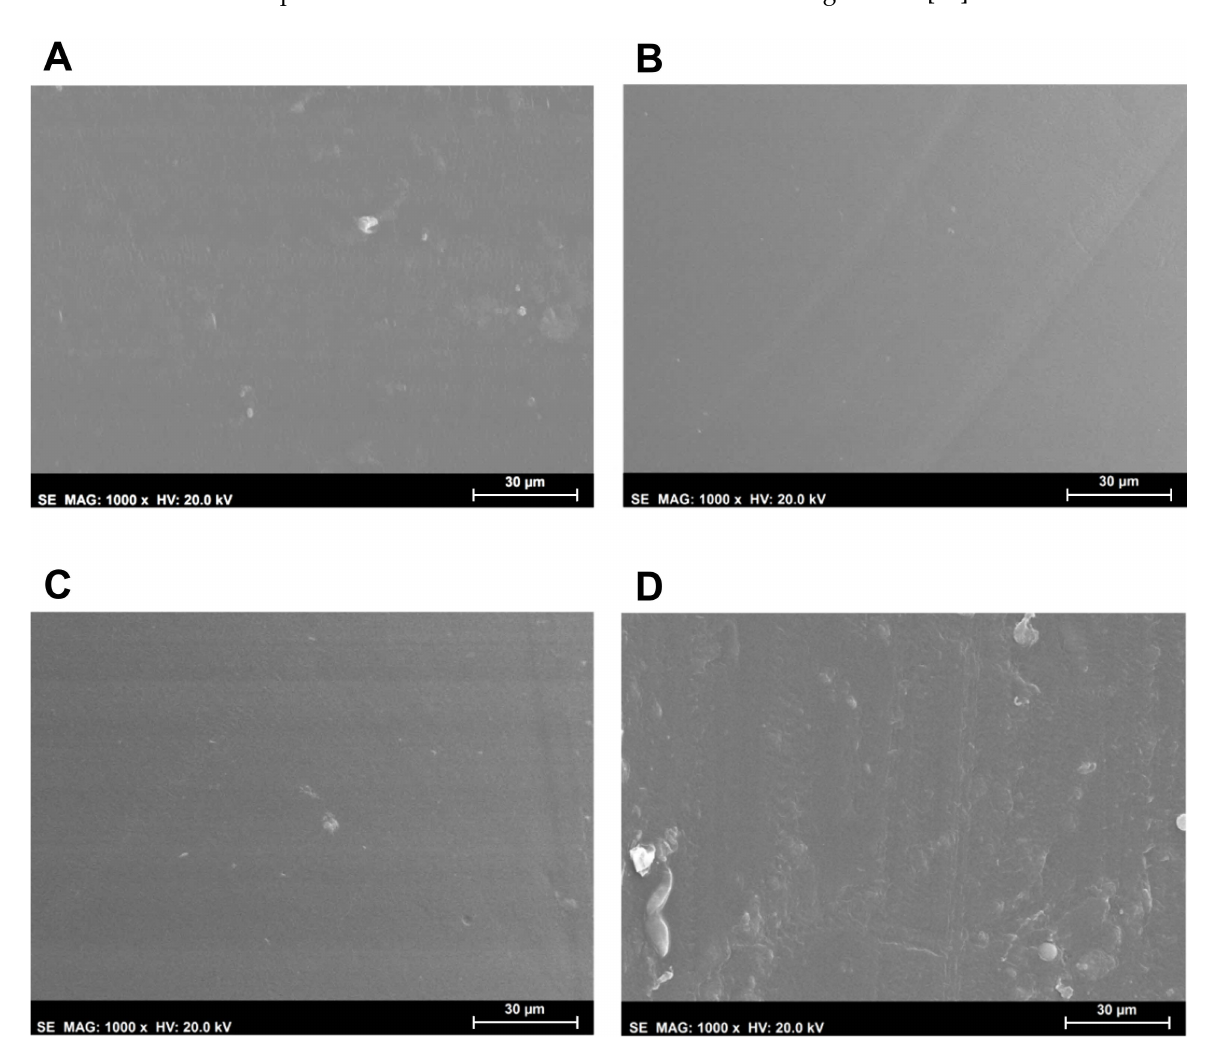
Figure 2. SEM micrographs (1000 × magnification, scale bar 30 µ m) of the PVA/PBO hydrogels: non-sterile ( A ), MW-3 ( B ), HHP ( C ), and PM ( D )